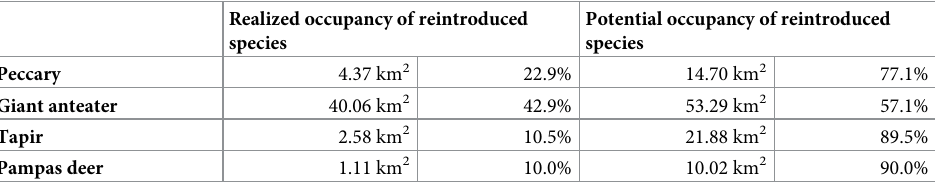
Table 2. Area and proportion of realized and potential occupancy of reintroduced species.